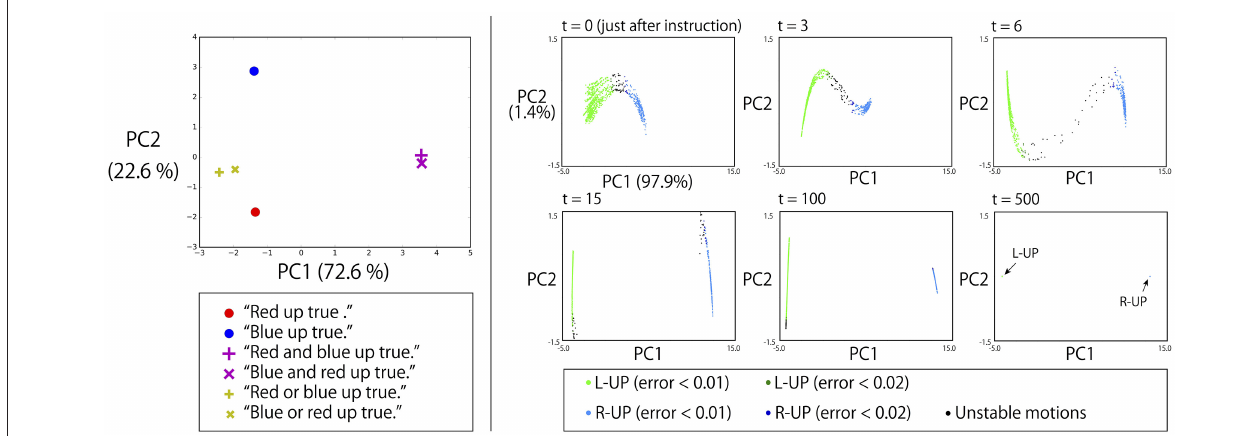
FIGURE 8 | Left : The memory cell states after giving a robot that is grasping red and blue flags some instructions whose objective part is one word, AND-concatenated, or OR-concatenated. The verb and the truth value are “up” and “true,” respectively. The AND-concatenated instructions are represented away from other instruction encodings in the PC1 direction. The pair of “red” and “blue” is represented in the PC2 direction. The “or” that directs the robot to raise either hand is embedded in the middle space between these two encodings. Right : To a robot waiting in the DOWN-DOWN posture with G-B flags after 2,048 different contexts, we gave the instruction “green or blue up true.” The memory cell states after the instruction ( t = 0) were arranged on an arch-shaped space (left top) . Each point corresponds to one specific context. When the activation was on the left side of the arch, the robot generated L-UP action and the internal states converged to the fixed-point corresponding to the UP-DOWN posture. In contrast, on the right side, the robot generated R-UP action, and the internal states converged to the fixed-point corresponding to the DOWN-UP posture. When the activation was on the topmost area of the arch, a little unstable action was generated. However, even in such cases, the internal states eventually converged to one of fixed-points, as shown in the right bottom panel.